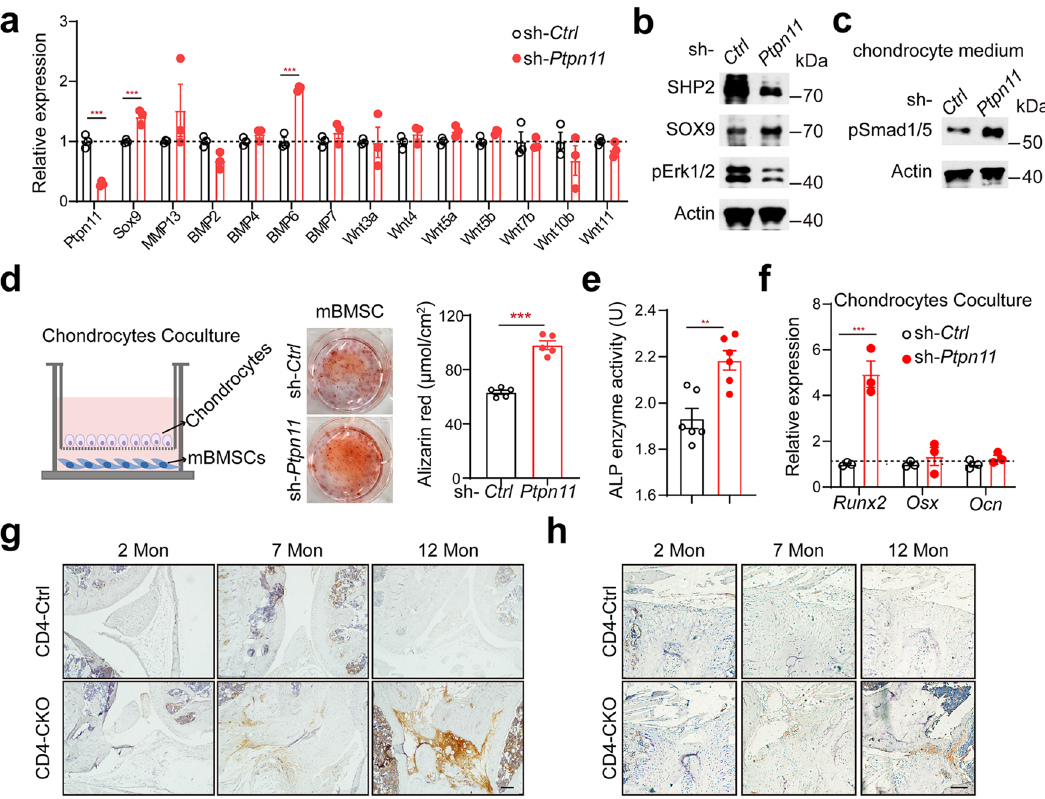
Fig. 7 Aberrant chondrocytes promote ectopic new bone formation through BMP6/Smad1/5 signaling. a RT-qPCR analyses of gene expression of chondrocytes after transfected with sh- Ctrl and sh- Ptpn11, respectively. ( n = 3). b Western blot analyses of chondrocytes of ( a ). c western blot analysis of phosphorylation of Smad1/5 protein levels in mBMSC stimulated with chondrocytes supernatant for 30 min. d Alizarin Red staining and quanti fi cation of mBMSC cocultured with chondrocytes for 14 days. ( n = 5). e, f ALP activity measurement ( n = 6) ( e ) and RT-qPCR analyses ( n = 3) ( f ) of osteogenic marker genes in mBMSC cocultured with chondrocytes for 7 days. e ** p -value = 0.0020. ( g and h ) Immunostaining analysis of pSmad1/5 protein levels in knee joint ( g ) and intervertebral disc ( h ). Scale bars: 100 μ m. a , d , e , f Data are presented as mean ± SEM. * p < 0.05, ** p < 0.01, *** p < 0.001, determined by two-tailed Student ’ s t -test. b – d , g , h Data are representative of three independent biological